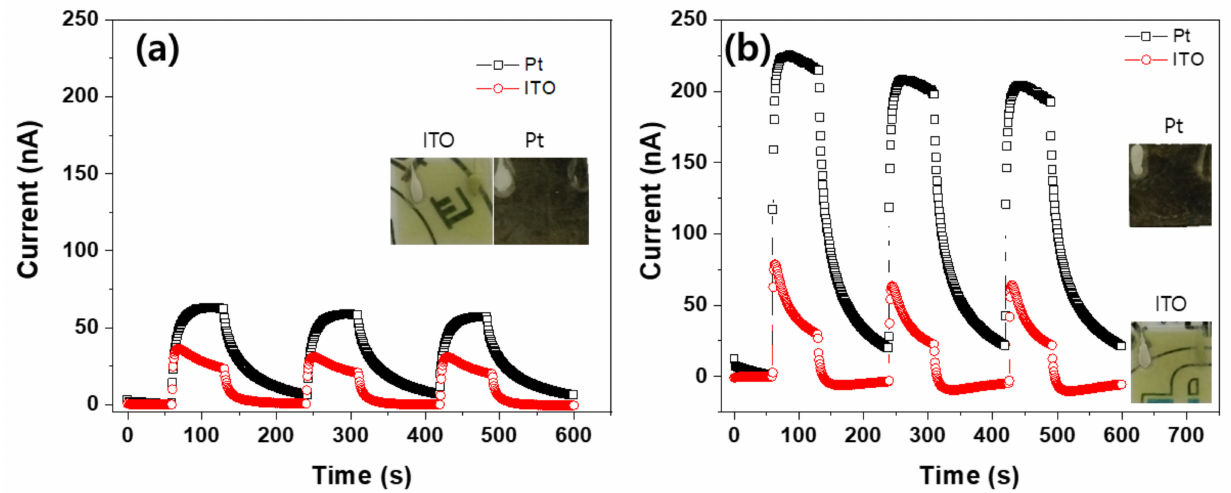
Figure 10. Platinum and ITO electrodes’ effect on the ZCN: ( a ) 25 mM ZCN and ( b ) 50 mM